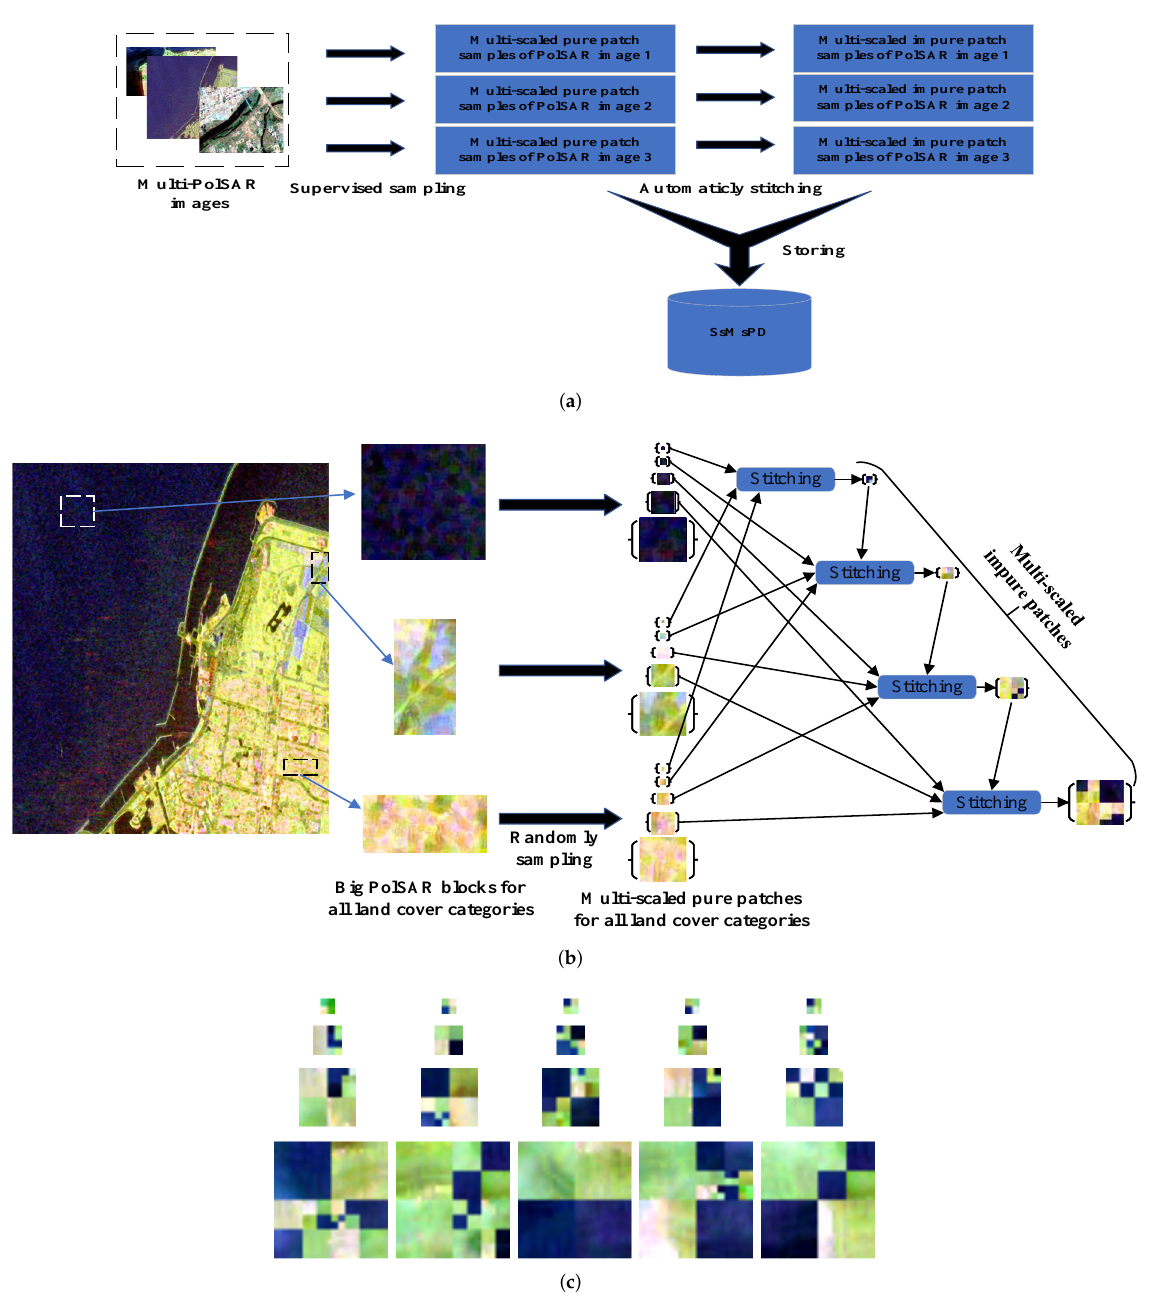
Figure 4. Dataset collection of the SsMsPD. ( a ) Overall process of generating the SsMsPD. ( b ) The specific sampling (for pure patches) and generating (for impure patches) process for each PolSAR image in the SsMsPD. ( c ) Some examples of impure patches with the size from 4 32 32 (the bottom ×